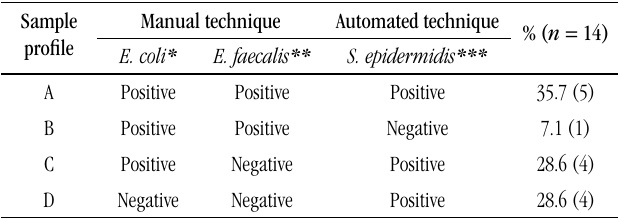
tABLE 2 – Classification of bacteriuria and culture-negative samples accord - ing to the profile found in